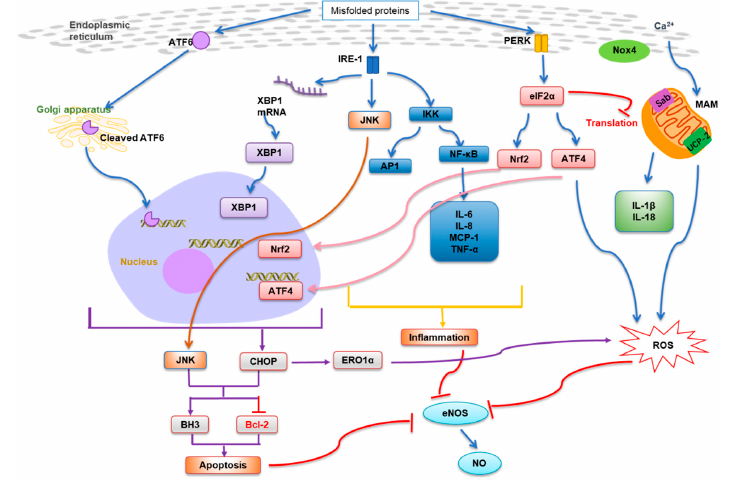
Figure 1. Schematic diagram showing regulation of endoplasmic reticulum (ER) stress and integration with other signaling networks. ER stress leads to inflammation, apoptosis, oxidative stress and reduced nitric oxide (NO) bioavailability, af- fecting vascular homeostasis.